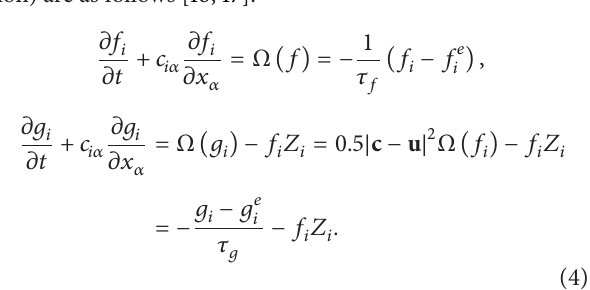
Figure 1: Schematic of analyzed